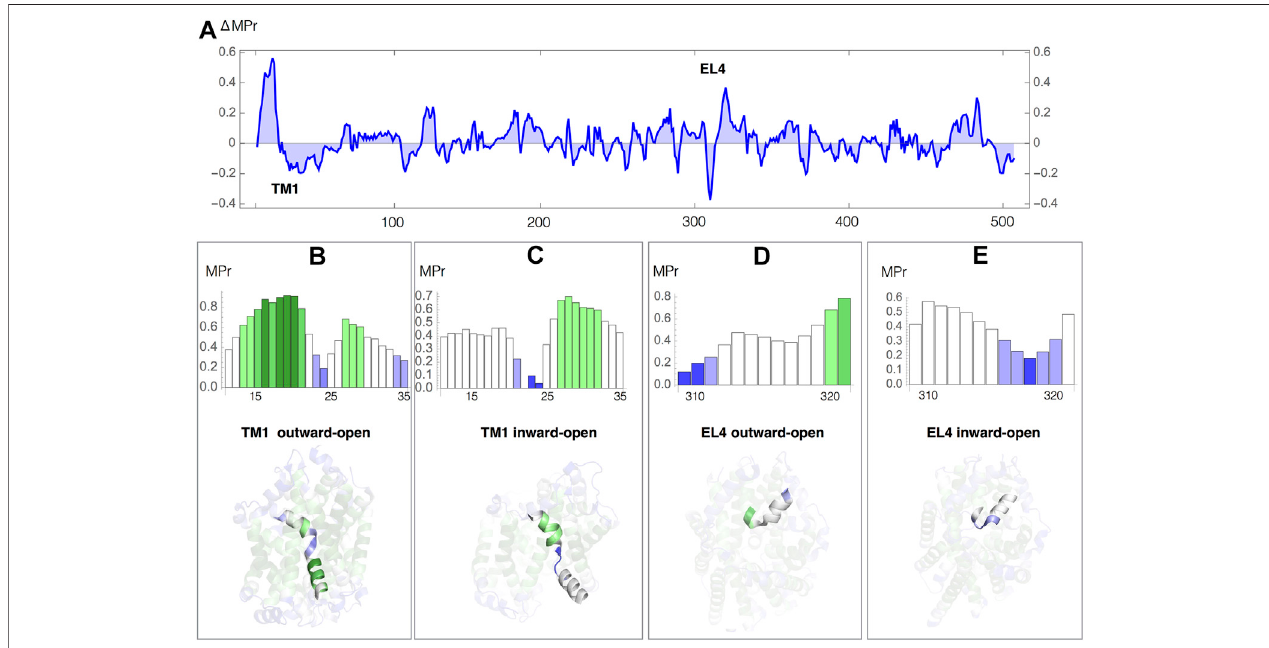
FIGURE 4 | Leu transporter: MPr score in the outward-open (PDB code 3tt1) and inward-open (PDB code 3tt3) conformations (A) Difference in MPr score ( Δ Mpr) betweenthetwoconformationsasafunctionofthesequenceposition;thepositionsofthehelicesTM1andEL4areindicated. (B – E) MProftheTM1andEL4helicesas afunctionofthesequence position, and TM1and EL4helices embedded inthe 3Dstructure,colored according tothe codede fi ned in Table2 ; (B) TM1, outward-open conformation; (C) TM1, inward-open conformation; (D) EL4, outward-open conformation; (D) EL4, inward-open conformation.